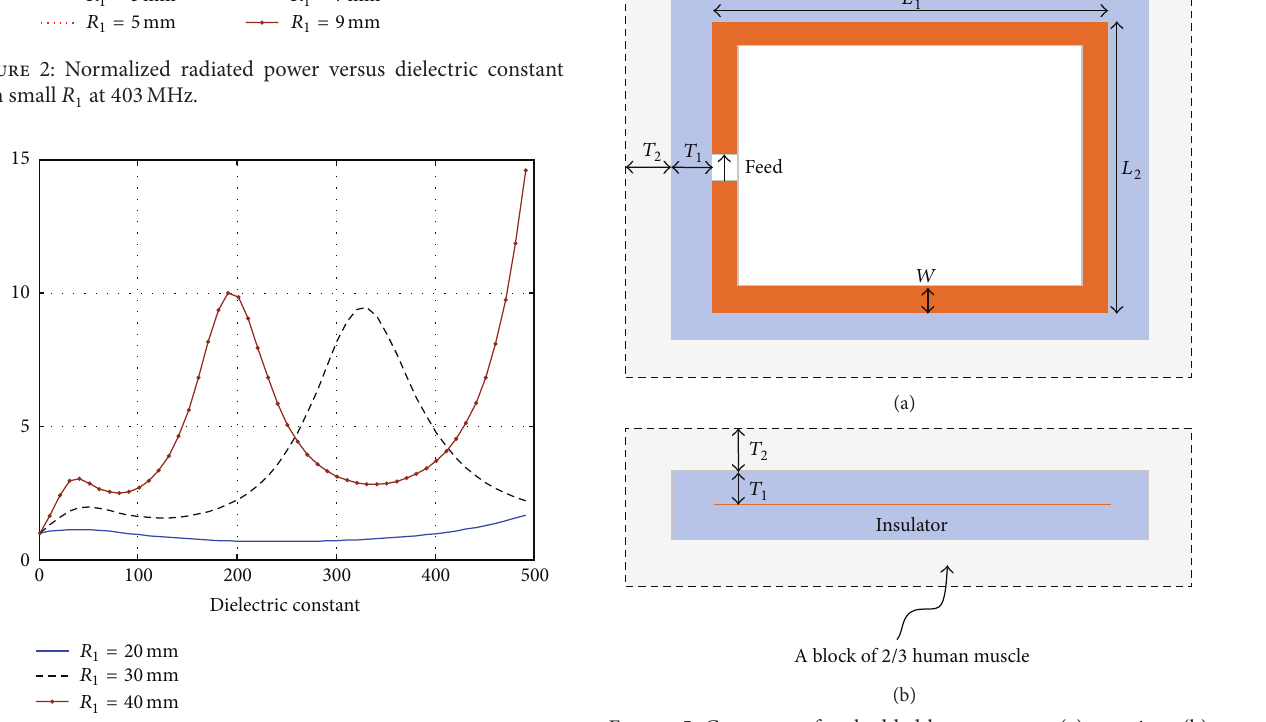
Figure 5: Geometry of embedded loop antenna: (a) top view; (b) side